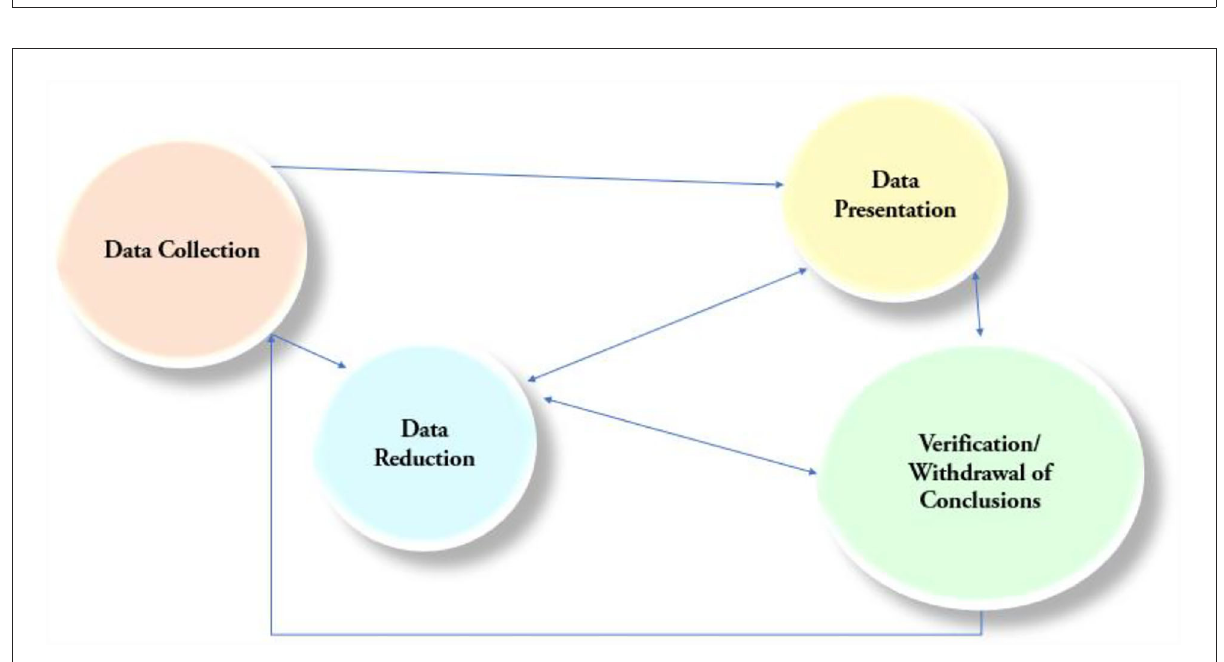
FIGURE2 Research data analysis